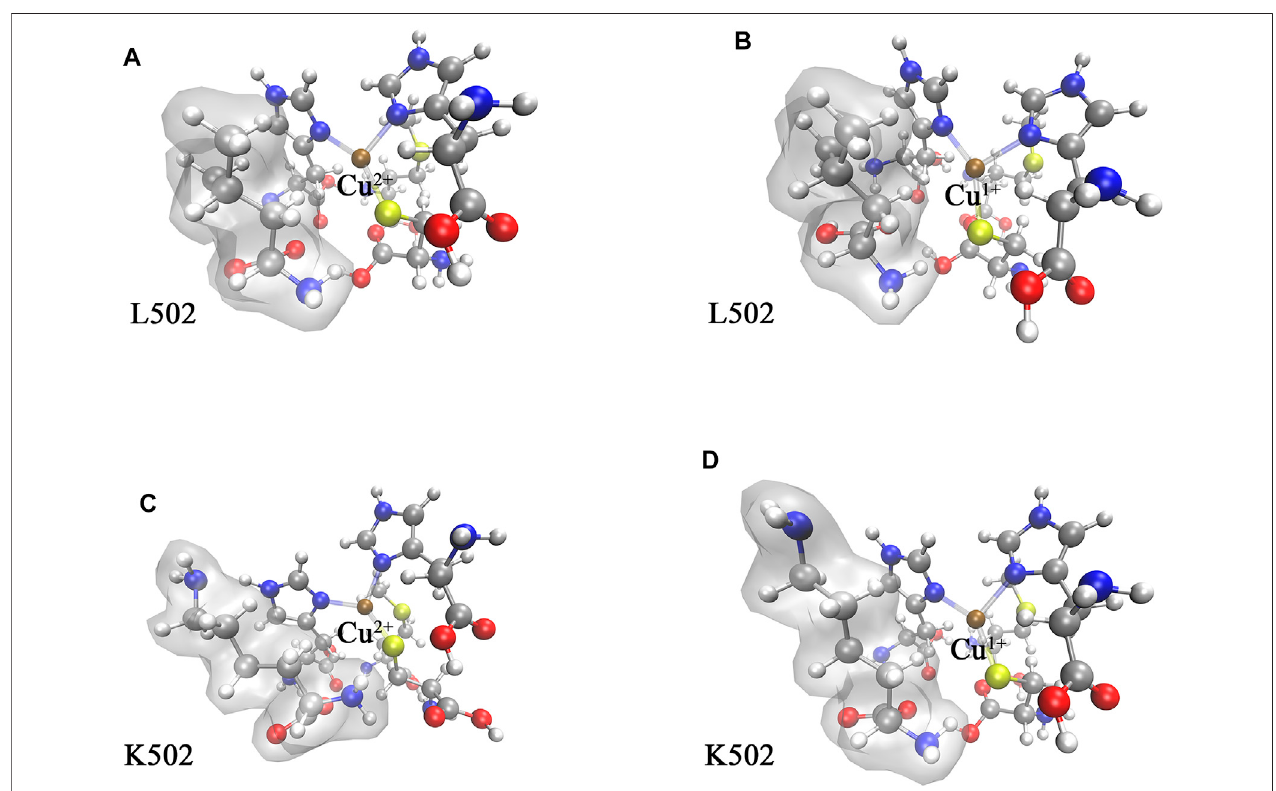
FIGURE 3 | The optimized structure of CueO T1 Cu active site cluster models in the water phase: (A) WT in the oxidation state, (B) WT in the reduction state, (C) L502K variant in the oxidation state, and (D) L502K in the reduction state. The colors correspond to atoms: brown for copper, yellow for sulfur, red for oxygen, blue for nitrogen, dark gray for carbon, and light gray for hydrogen. The amino acid residue 502 was highlighted by adding a transparent molecular surface.